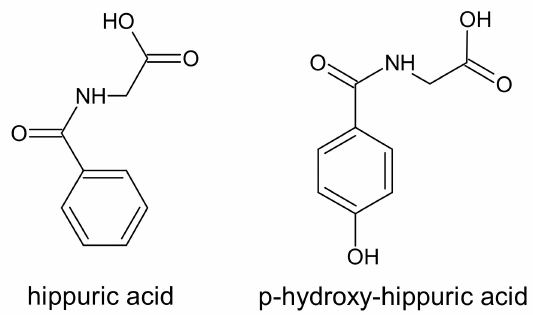
Figure 4. Chemical structure of hippurate derivatives, classified as protein-binding uremic toxins.